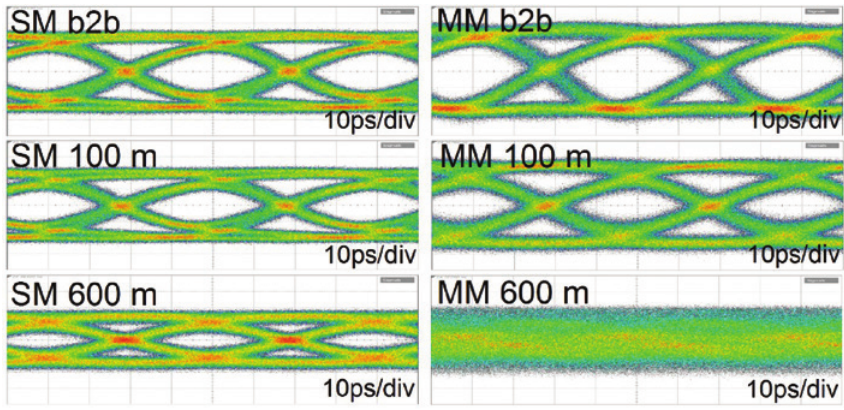
Figure 15: Influence of dispersion on 25 Gb/s eye diagrams for MM and SM VCSELs at different OM4 MMF lengths [13].